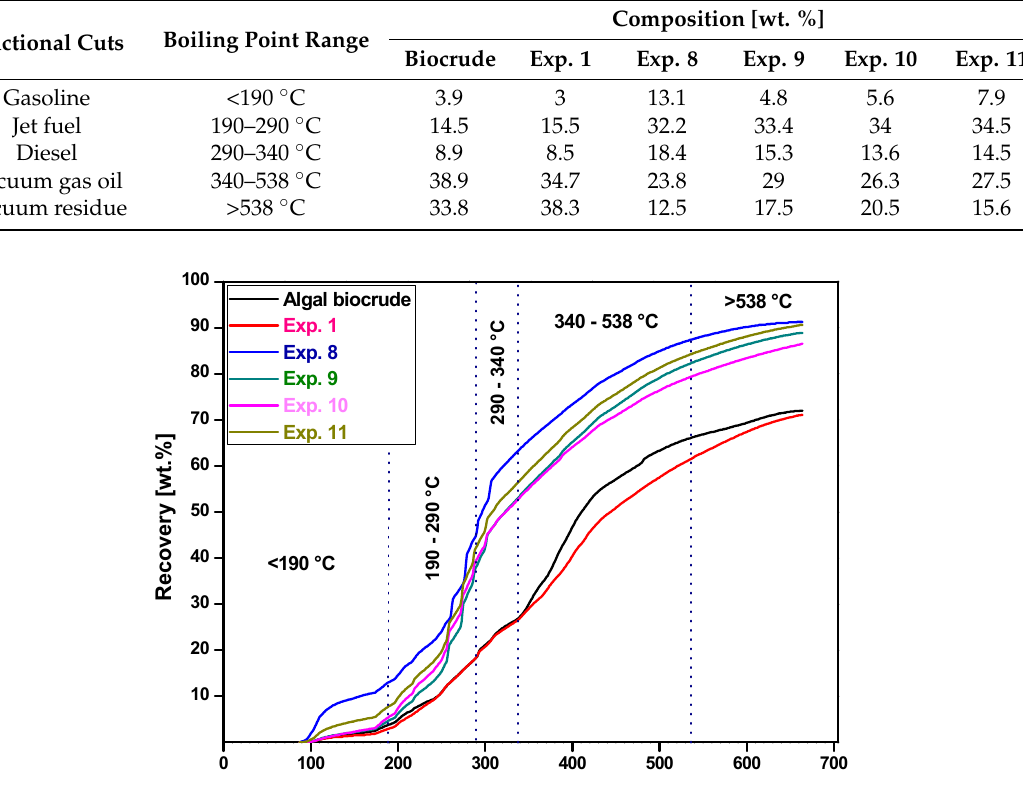
Figure 2. Boiling point distribution of biocrude and upgraded oil samples, obtained by simulated distillation.